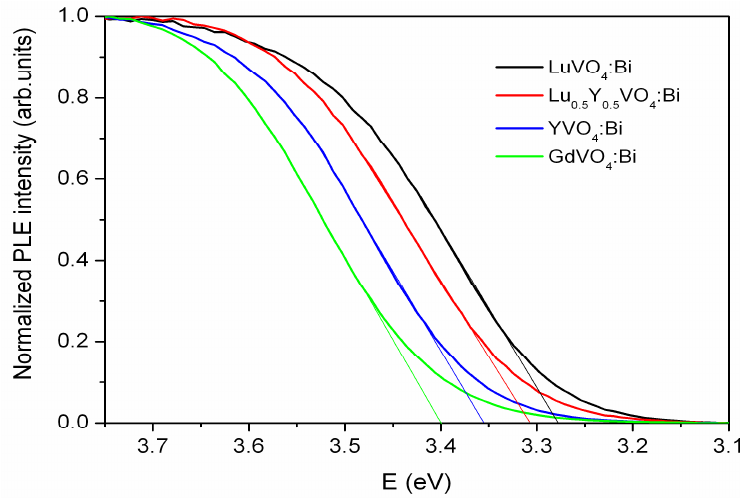
Figure 8. Estimation of the excitation edge of the Bi-related emission ( λ em = 570 nm) registered in the studied R VO 4 :Bi(1%) samples at room temperature.